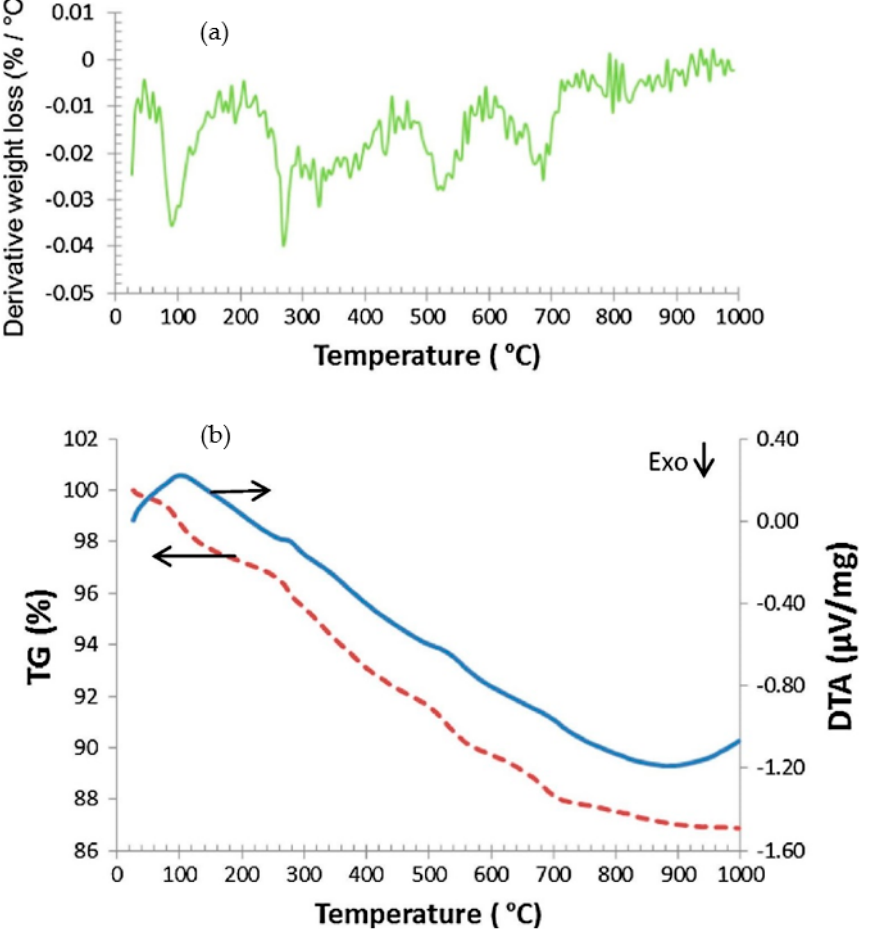
Figure 7. ( a ) DTA and ( b ) TGA analysis .